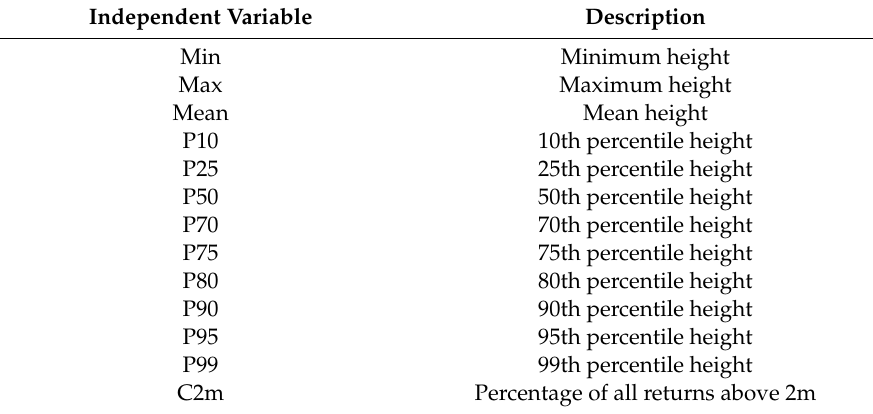
Table 1. ICESat-2-derived metrics used for estimating